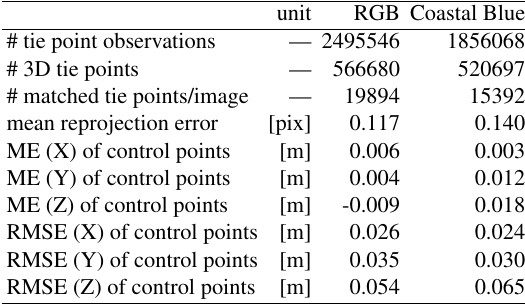
Table 2. Results of bundle block adjustment